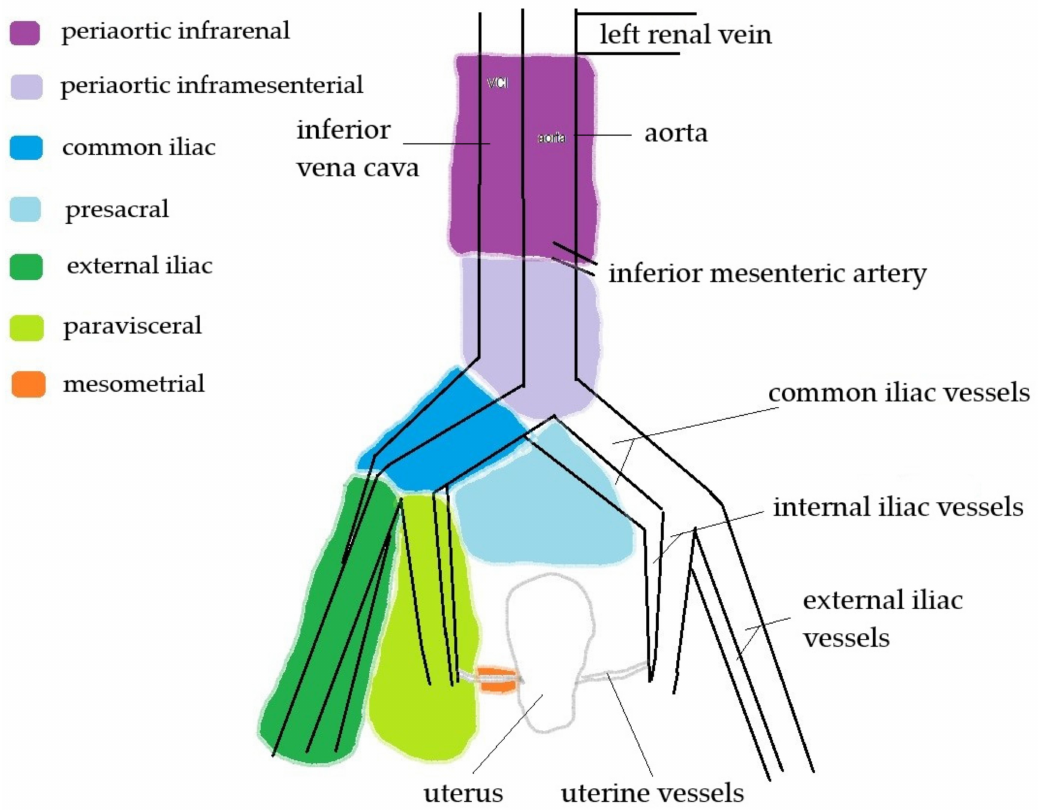
Figure 1. Schema of lymph node